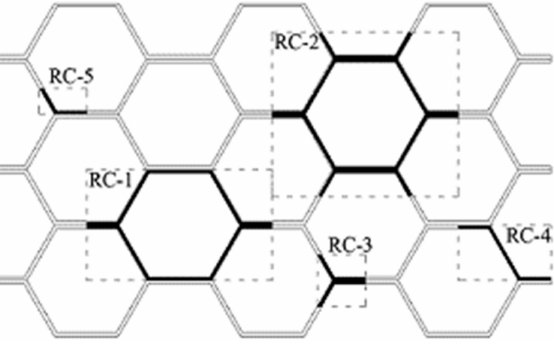
Figure 1. Representative unit cell (RC) models for hexagonal honeycomb (HC)